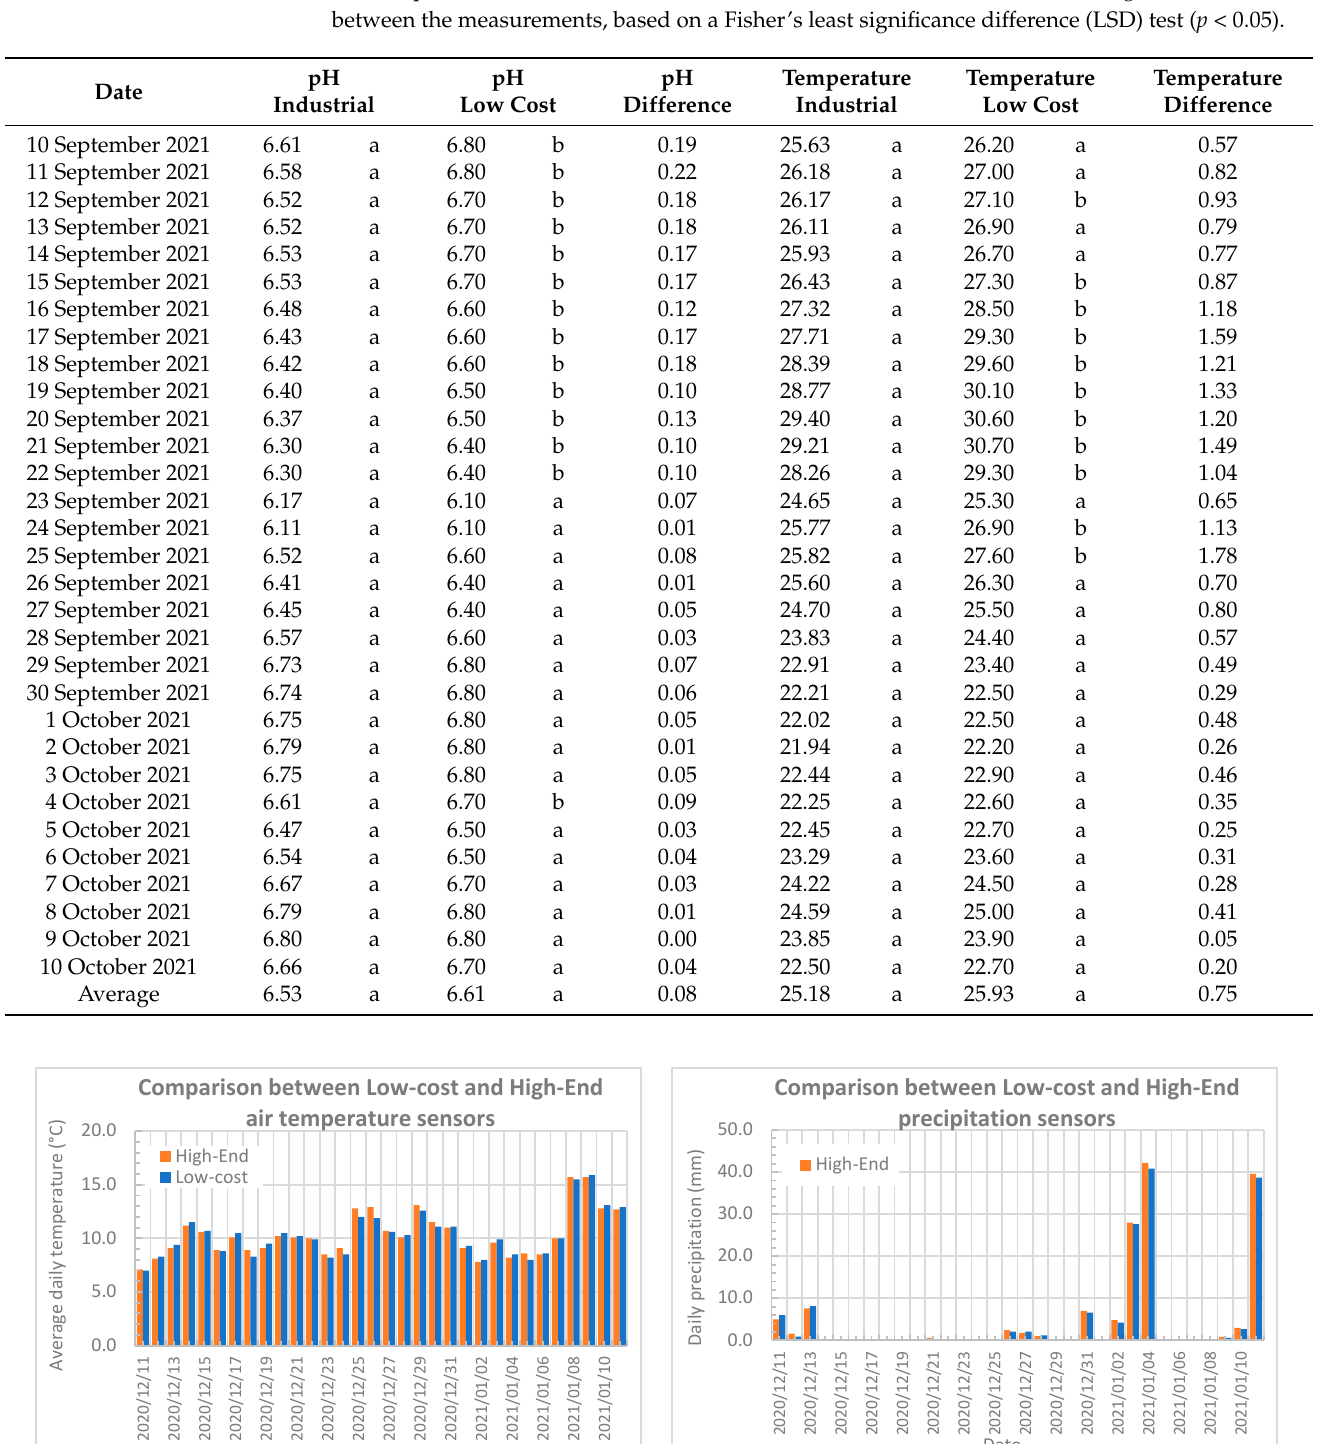
Table 1. Comparison of the measurements of the low-cost and industrial sensors. The different letters accompanying daily means and monthly average values of each distinct measurement type (pH and temperature) for each set of the industrial and low-cost sensors indicate a significant difference between the measurements, based on a Fisher’s least significance difference (LSD) test ( p < 0.05).